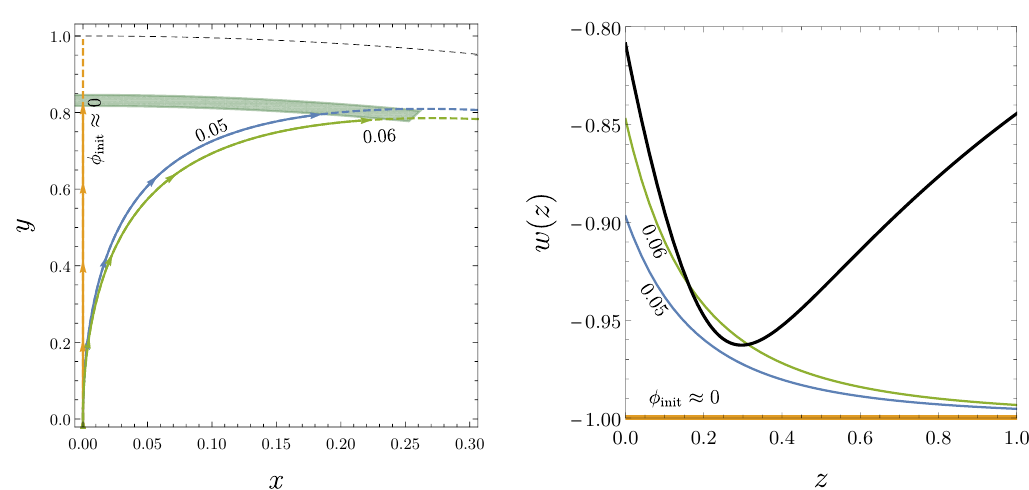
Figure 4 . The ( x; y ) trajectories of the quintessence (cid:12)eld (left) and its equation of state (right) for a range of initial misalignment. For this plot, we have chosen the values ( a; b ) = (0 : 99 ; 2 : 4), for which only (cid:12)ne-tuned initial conditions are consistent with data. Curves are labeled with the initial (cid:12)eld value (cid:30) init =M Pl and show the minimum and maximum allowed values in addition to a trajectory that is excluded by data.